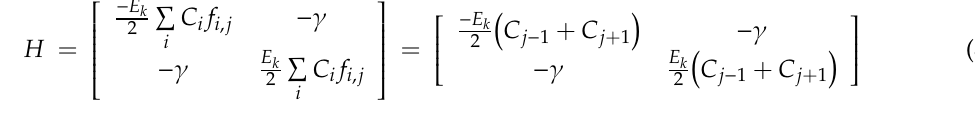
Figure 13. The simulation result of the proposed 2 × 2 bit multiplier.